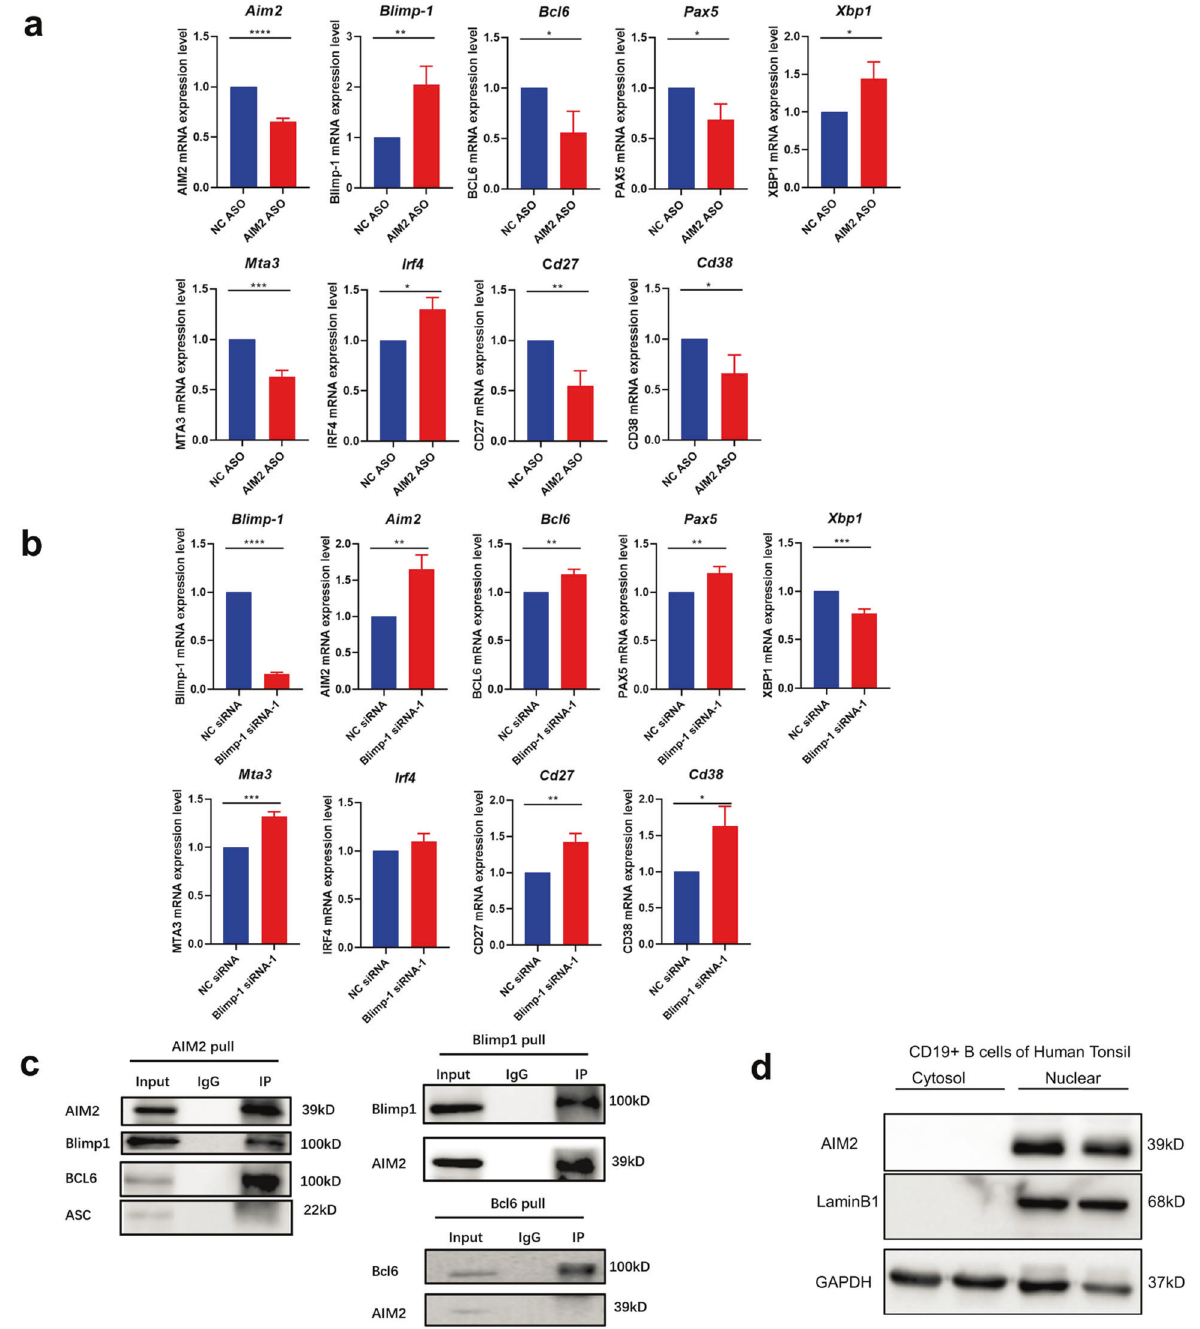
Fig. 5 AIM2 regulates Blimp-1 and Bcl-6 expression and directly binds to Blimp-1 and Bcl-6. a AIM2 expression was knocked down in B cells by AIM2 ASO, and the mRNA expression of Bcl6, Pax5, Xpb1, Mta3, Cd27 , Cd38 , Blimp-1 , and Irf4 was detected by qRT-PCR. b Blimp-1 expression was knocked down in B cells by Blimp-1 siRNA, and the mRNA expression of Bcl6, Pax5, Xpb1, Mta3, Cd27 , Cd38 , Aim2 , and Irf4 was detected by qRT-PCR. c The Co-IP of AIM2 with Blimp-1, Bcl-6, and ASC. d The nuclear expression of AIM2 in human tonsil B cells. Horizontal bars represent the mean ± SEM. * p < 0.05, ** p < 0.01, *** p < 0.005, **** p <